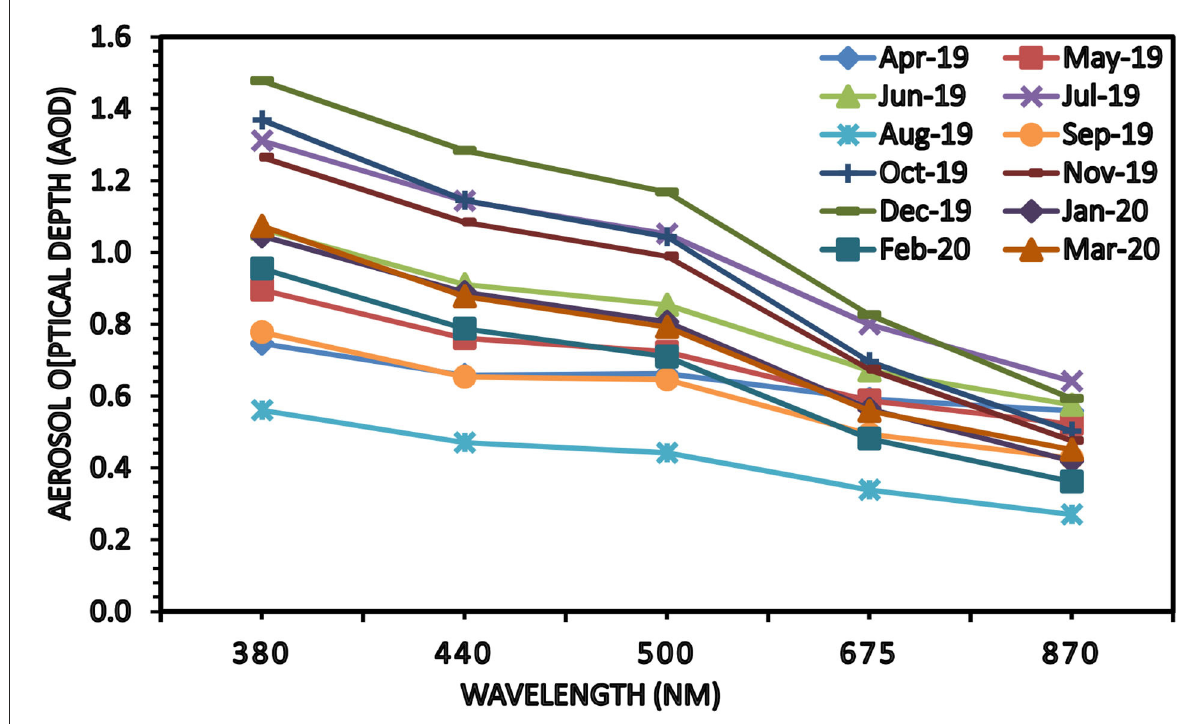
FIGURE6 Spectral variation in AOD at different wavelengths 380, 440, 500, 675, and 870nm over Varanasi during the study period (April 2019–March